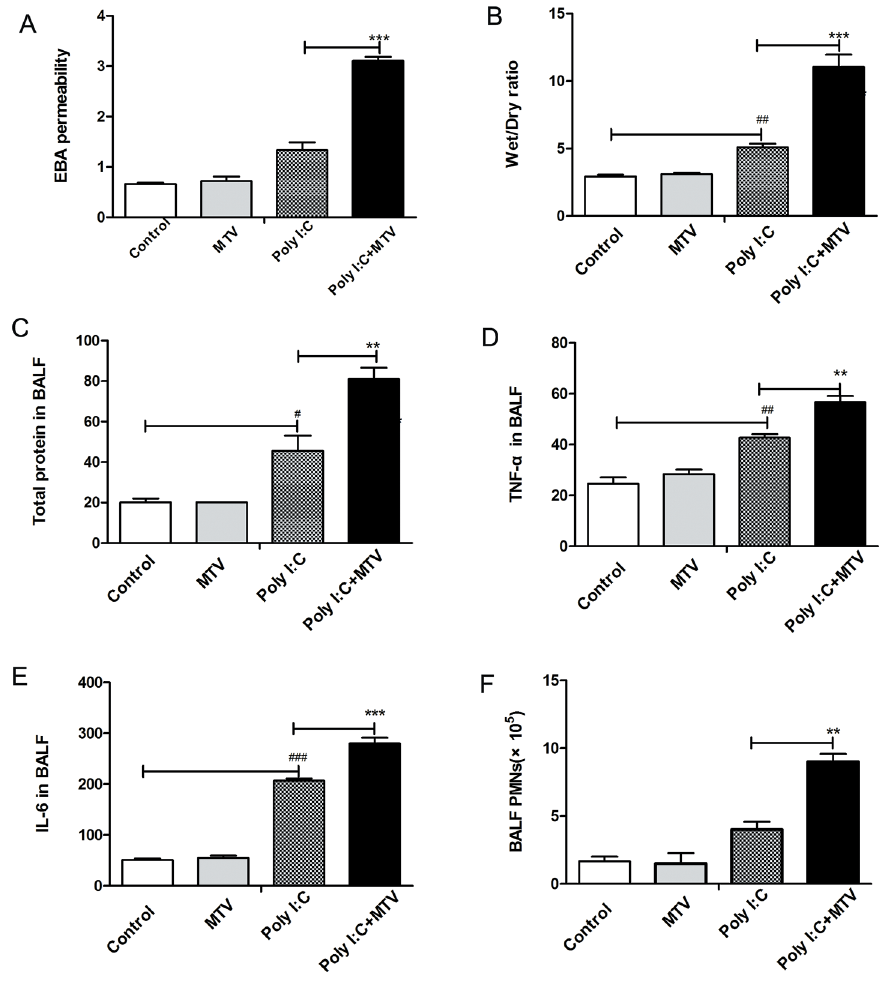
Figure 1. Alterations in (A) EBA permeability, (B) wet:dry ratio of lungs, and (C) levels of total protein, (D) TNF- α and (E) IL-6, as well as (F) PMNs numbers in BALF at 4 h after poly(I:C) and MTV treatment. Data are presented as means ± SEM (n = 15) and com- pared by one-way ANOVA and Student-Newman-Keuls test. For comparing the poly(I:C) group with the untreated control group # P < 0.05, ## P < 0.01, ### P < 0.001. For comparing the poly(I:C) + MTV group with the poly(I:C) group ** P < 0.01, *** P <